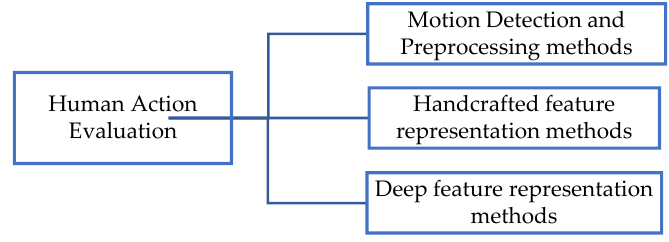
Figure 2. The framework of reviewed action evaluation research works.